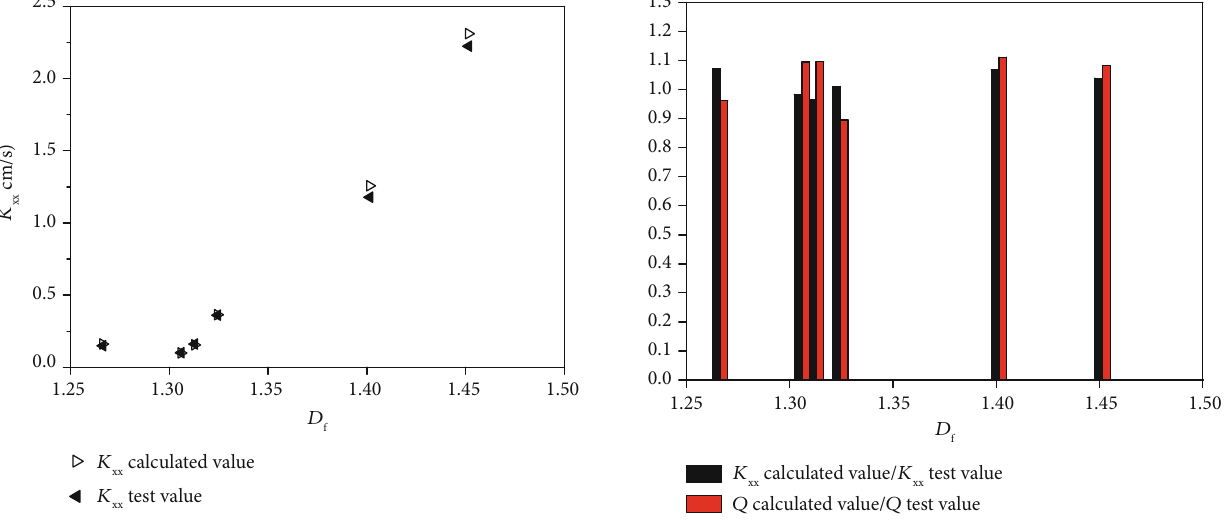
Figure 22: Theoretical calculated value/water injection test measured histogram of K